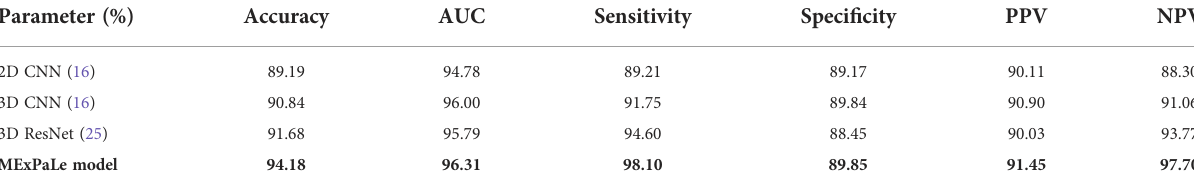
TABLE 4 Performance of